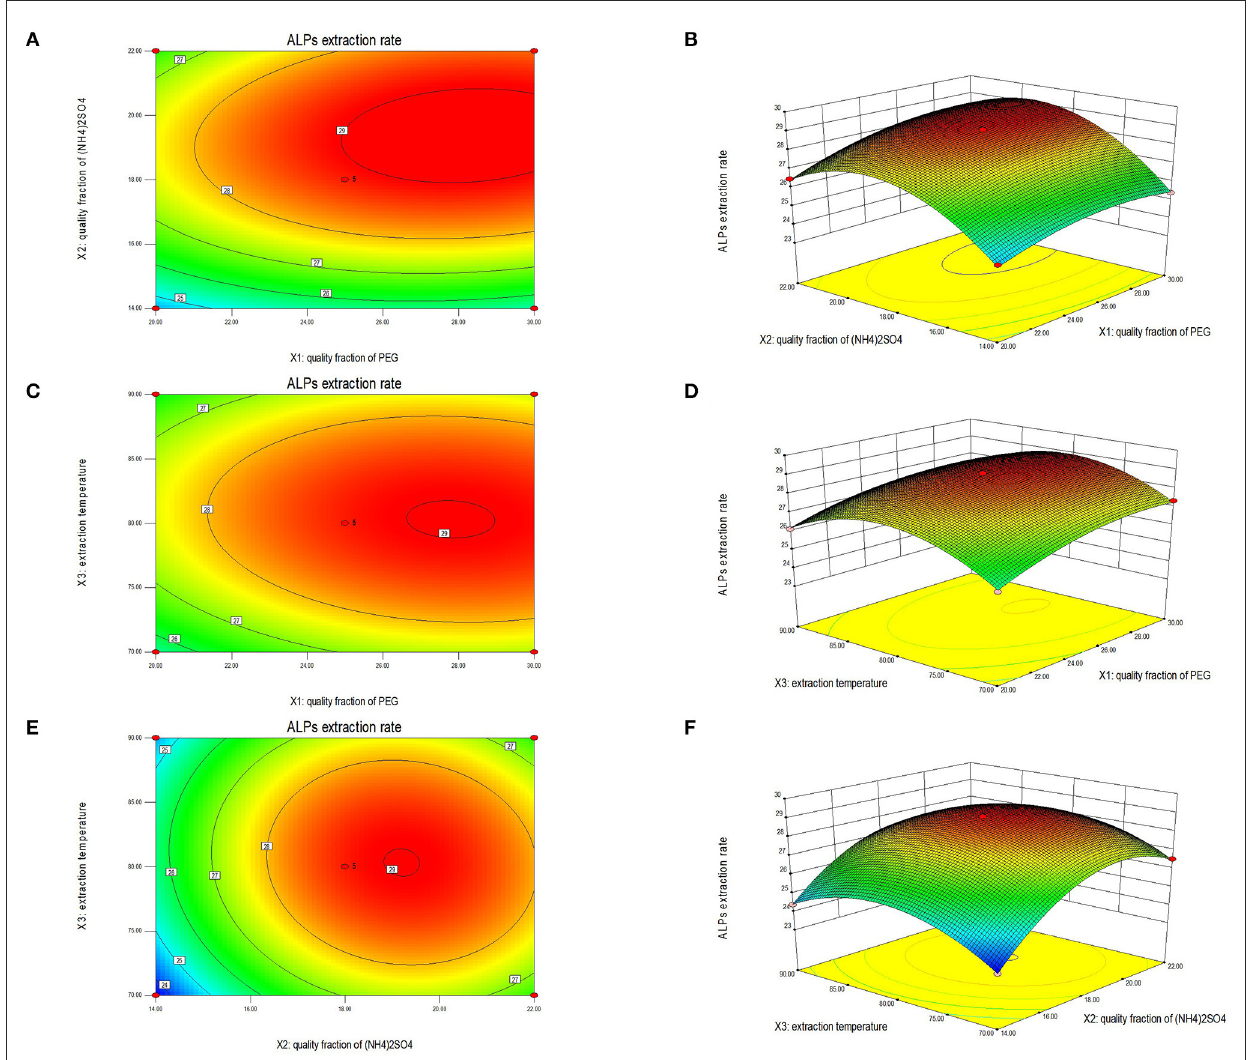
FIGURE2 The 2D contour plot and 3D response surface showing the effect of PEG quality fraction and (NH 4 ) 2 SO 4 quality fraction (A, B) , PEG quality fraction and extraction temperature (C, D) , (NH 4 ) 2 SO 4 quality fraction and extraction temperature (E, F) on the extraction rate of ALPs.